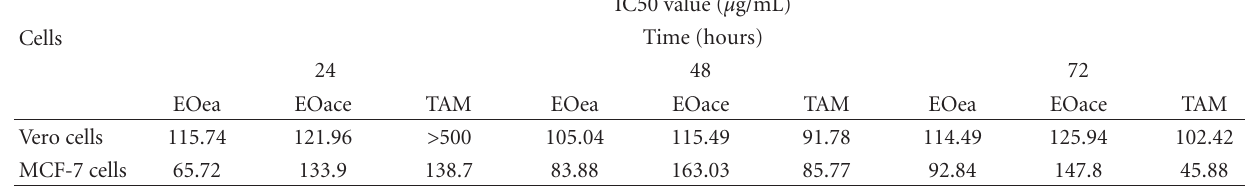
Table 1: Cytotoxic concentrations (IC 50 values) of EOea and EOace extracts against MCF-7 and Vero cells at di ff erent periods of treatment.